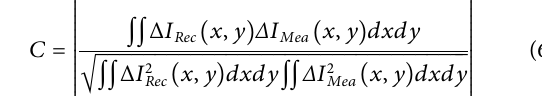
optical fi eld can be reconstructed using Equation 1 .